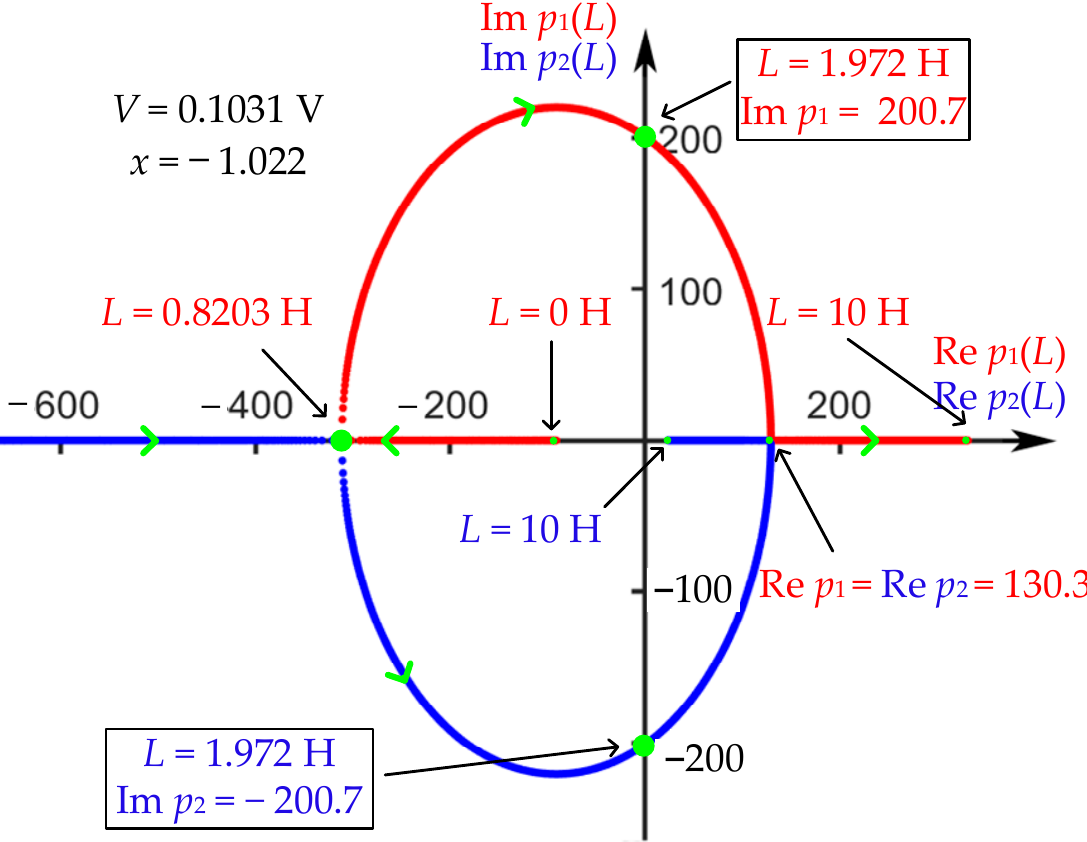
Figure 13. Variation in the real and imaginary parts of the poles of the admittance function in the oscillation circuit with the external capacitance (if V = 0.1031 V).